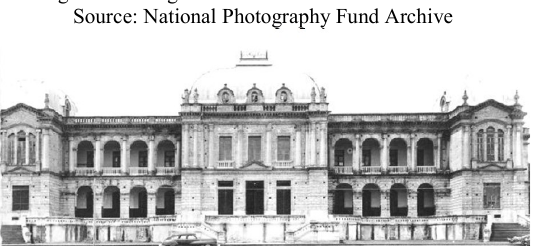
Figure 2. Design for the frontal facade of the BMH. Source: National Photography Fund Archive